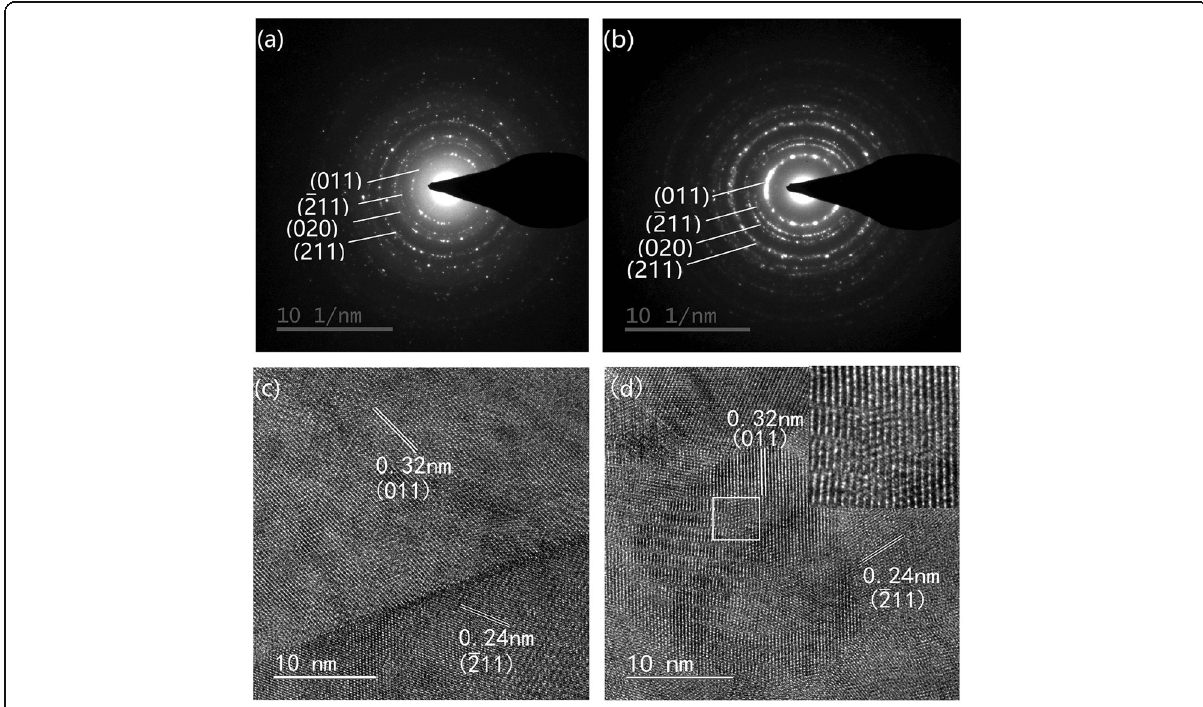
Fig. 3 a and b SAD patterns, c and d HRTEM images of VO and